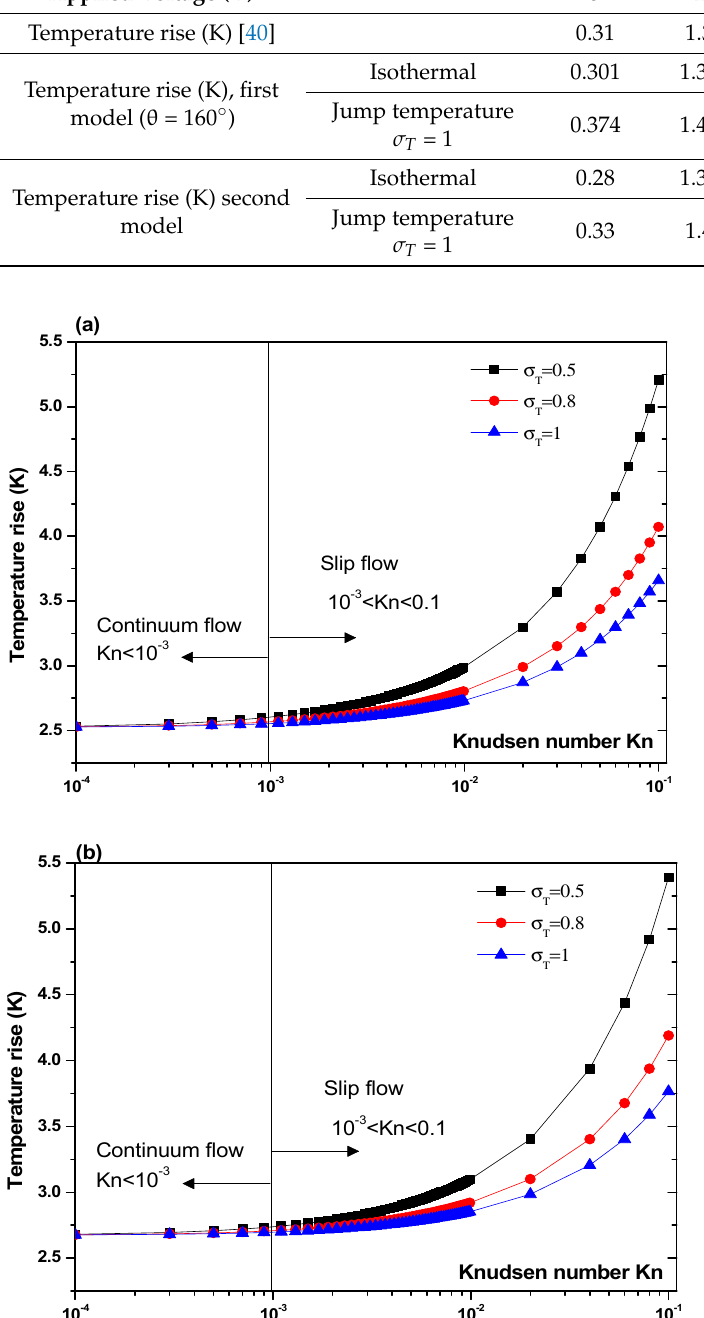
Figure 7. Temperature rise versus the Knudsen number for first structure and for V rms = 15 V, and: ( a ) θ = 40°, ( b ) θ = 160°.